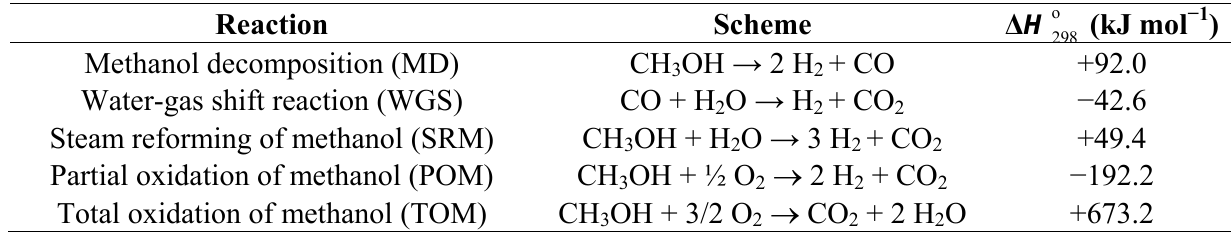
Table 1. Some reactions inside a microreformer and their standard enthalpies of formation [8,9].